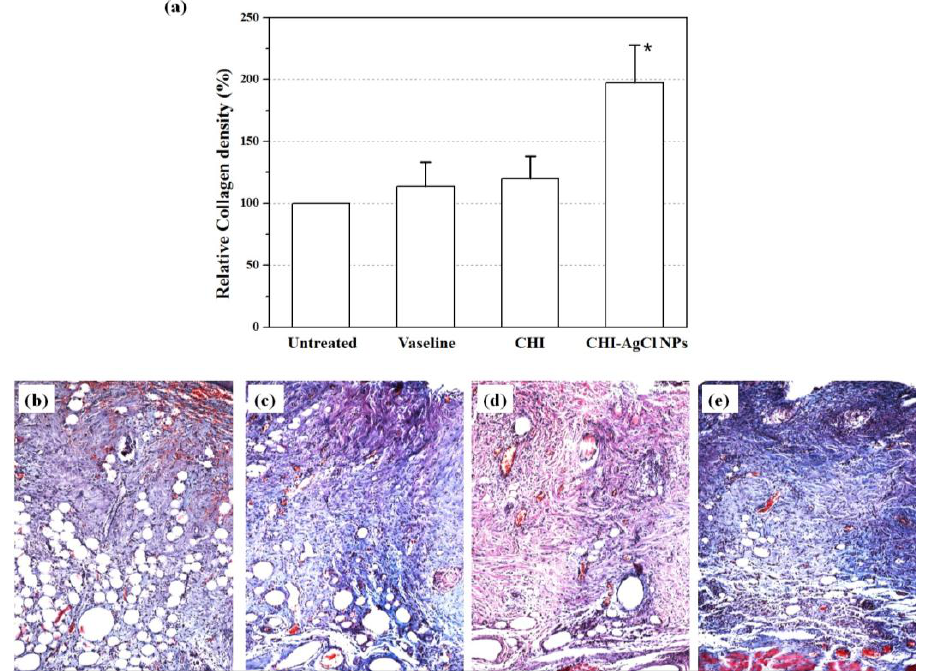
Figure 5. ( a ) The relative collagen density in burn induced skin damage at treatment Day 14. Evaluation of histopathology in the healing effect of untreated ( b ); Vaseline ( c ); CHI ( d ); and CHI-AgCl NPs ( e ) ointment using MT staining. The photographs were taken at an original magnification of ×100. The data are mean ± SD of 10 independent experiments. * indicates data with a statistical significance ( p < 0.05) compared with the untreated and CHI-AgCl NPs ointment-treated groups.